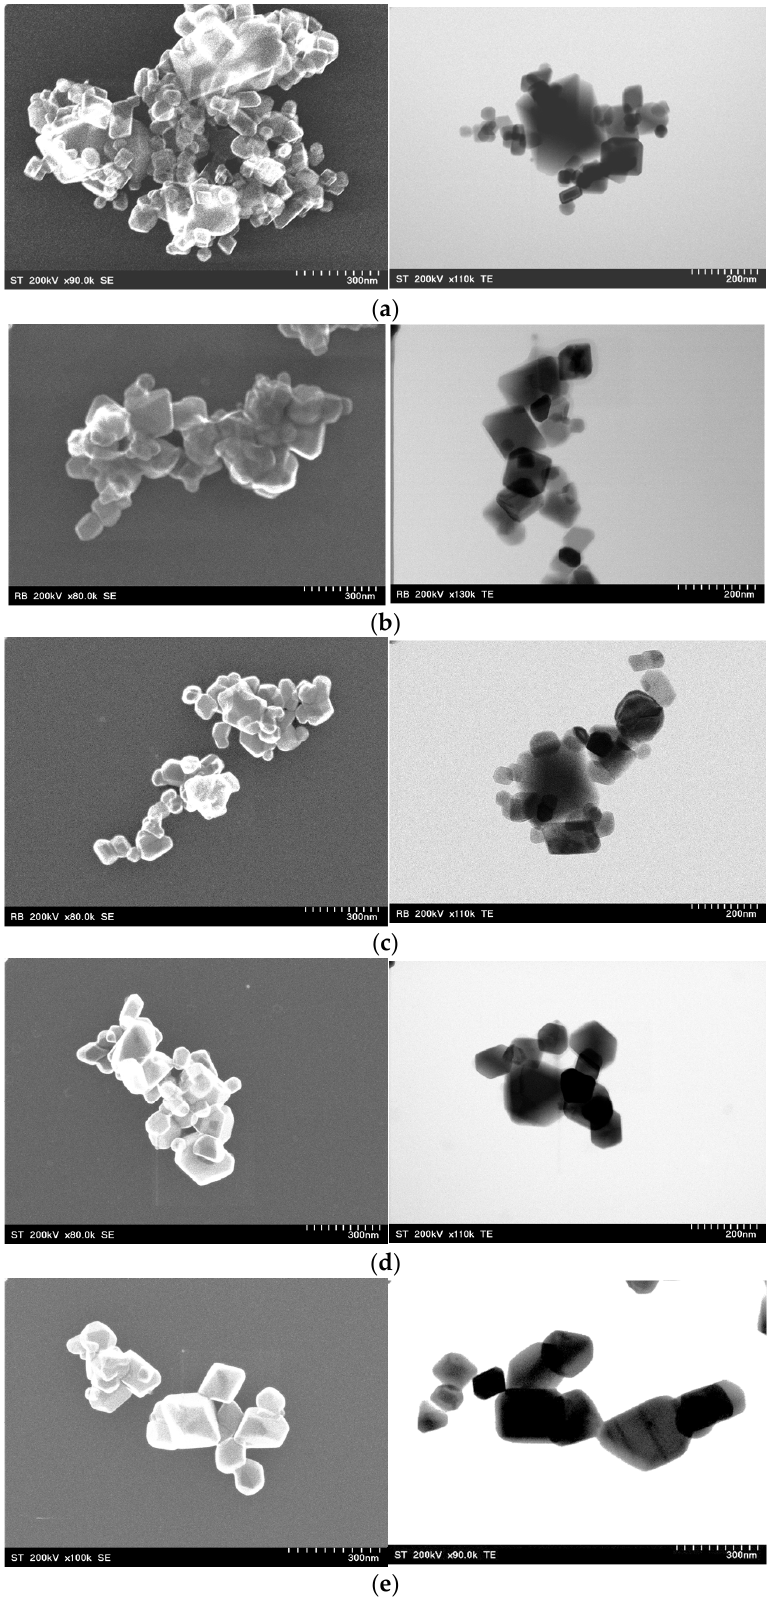
Figure 6. SEM and TEM images of ( a ) CoCr 2 O 4 ( b ) Co 0 . 75 Ni 0 . 25 Cr 2 O 4 ( c ) Co 0 . 5 Ni 0 . 5 Cr 2 O 4 ( d )